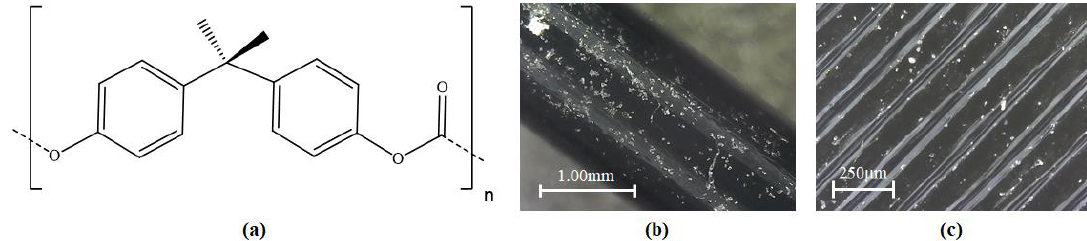
Figure 6. PC ( a ) chemical structure; ( b ) raw material; and ( c ) final processed material.